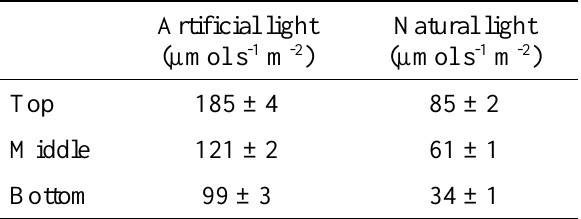
Table 1. Mean intensity and standard error (n = 24) of photosynthetically active radiation on different levels of the plant towers, measured separately for artificial light only at planting time (17 January), and natural light only on a typical cloudy day during early growth (20